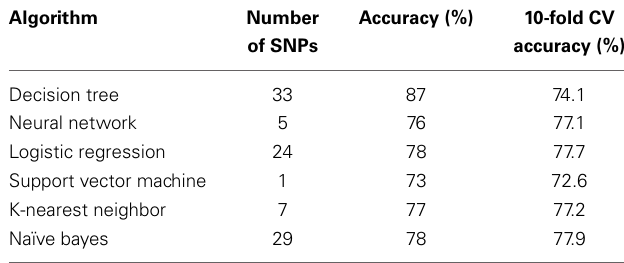
Table 2 | Relative performance across machine learning